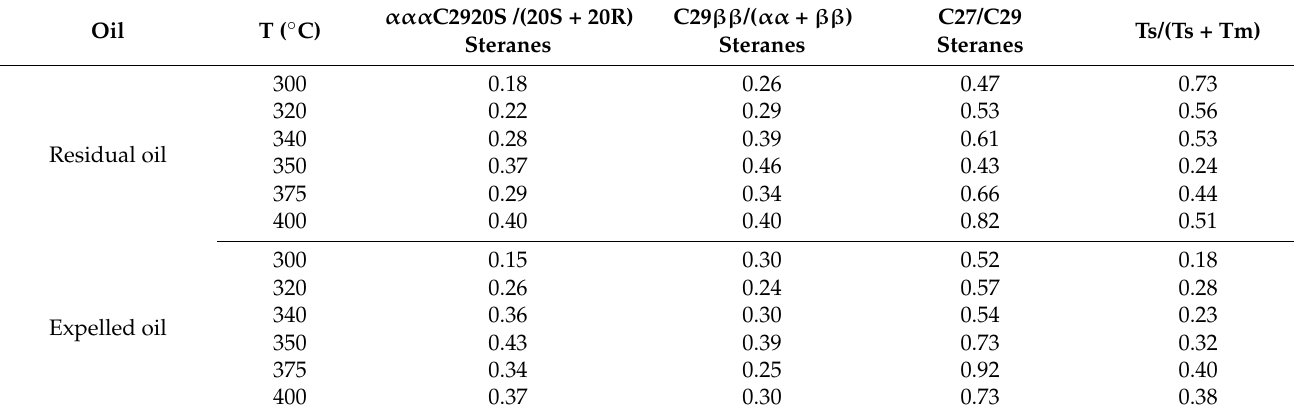
Table 4. Temperature pyrolysis temperatures from sediment sample